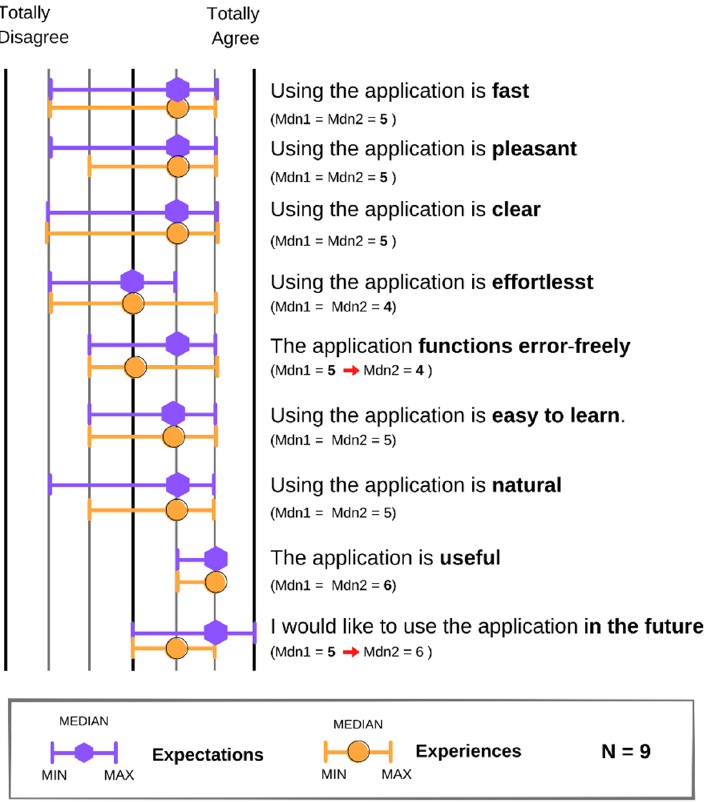
Figure 8. Expectations and experiences with VR platform. A seven-point Likert scale was used.